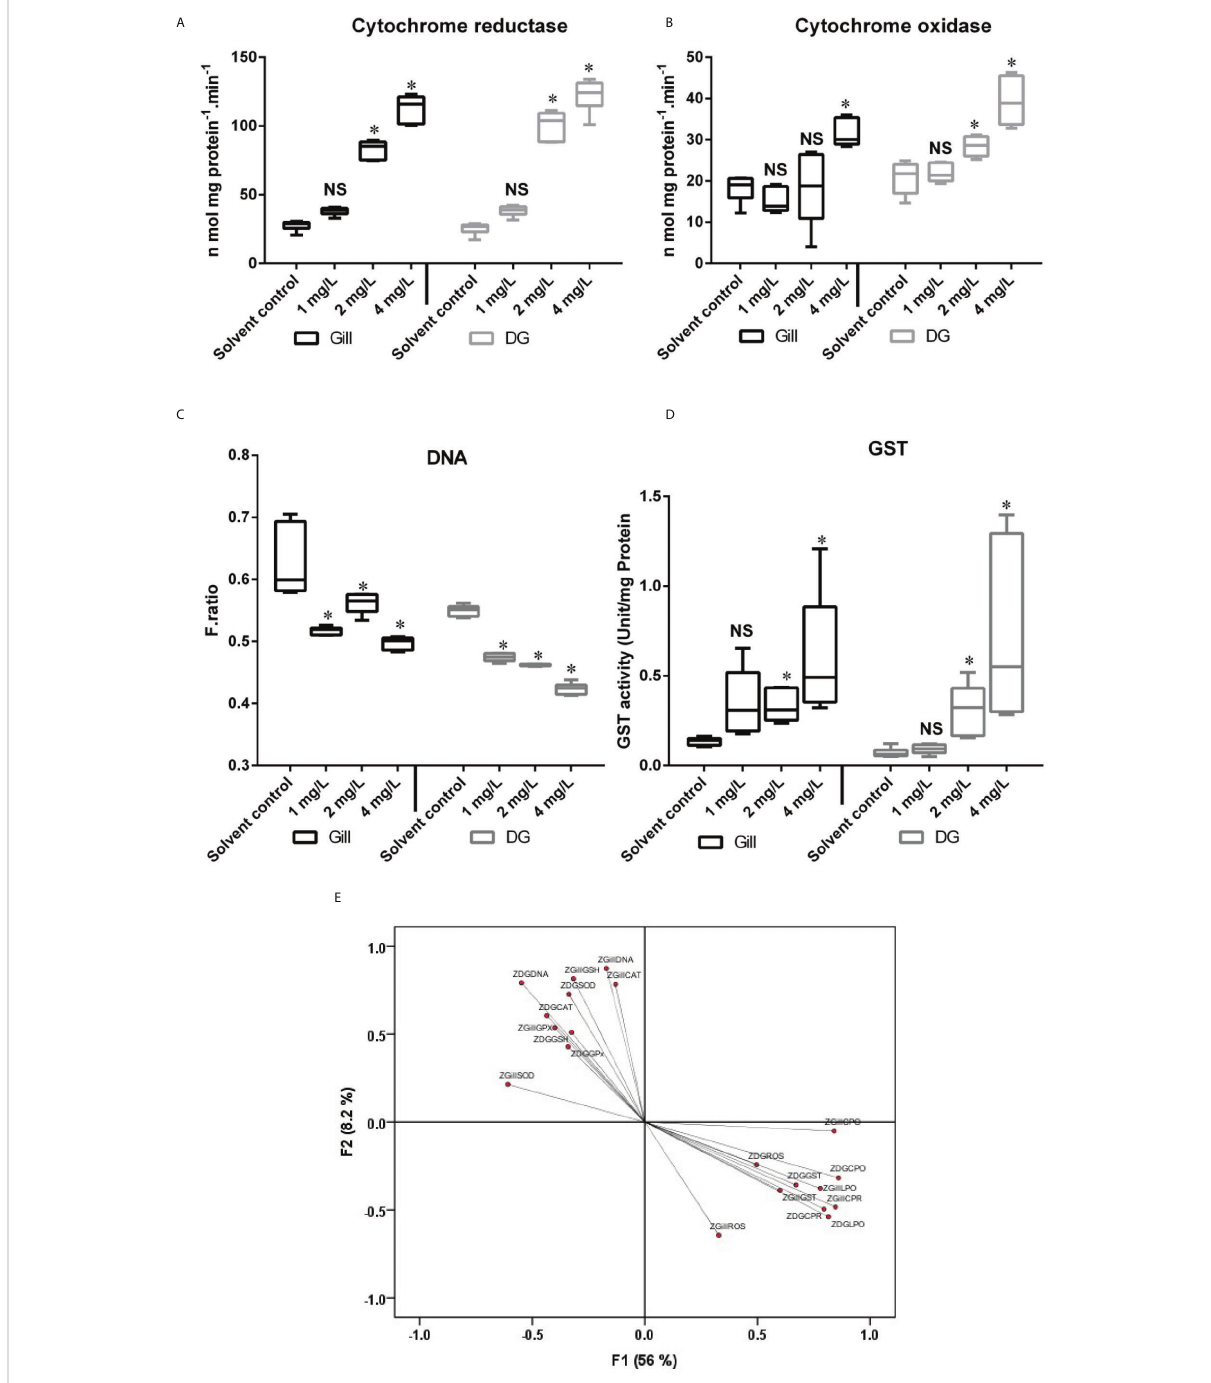
FIGURE 1 Showing the level of (A) Cytochrome c reductase, (B) Cytochrome c oxidase, (C) DNA damage, (D) GST activity and (E) Factor loading F1 and F2 for different biomarkers analyzed in mussel exposed to different concentration of naphthalene. The line in each box represents median and whiskers represents the upper and lower 95% con fi dence intervals of the mean of six determinations using samples from different preparations. One-way analysis of variance (ANOVA) followed by Tukey ’ s post hoc test was used. The signi fi cant difference between control and exposure groups were indicated with asterisks ( P < 0.05); NS, No signi fi cant difference with respective control group. The Z-represent that the data is normalized. DG, Digestive